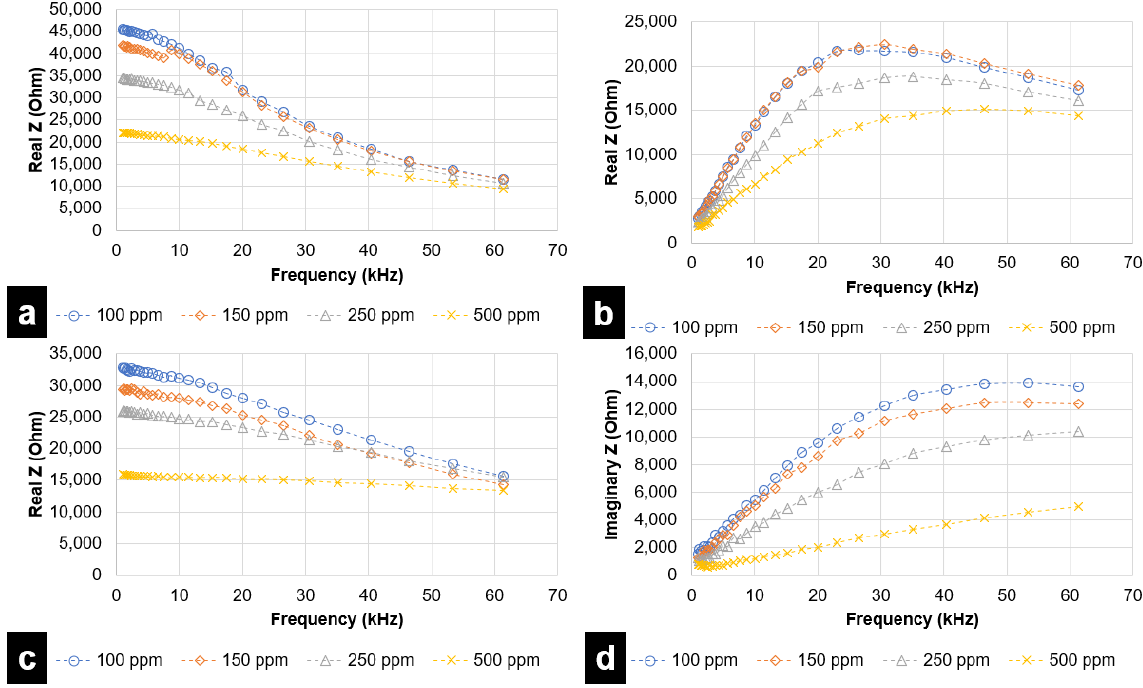
Figure 8. EIS analysis for GMP (umami) and sucrose (sweet), in the range of 1 kHz to 62 kHz, for inkjet printing-based IDE sensor in terms of ( a ) Resistive Impedance vs. Frequency (GMP) ( b ) Reactive Impedance vs. Frequency (GMP) ( c ) Resistive Impedance vs. Frequency (sucrose) ( d ) Reactive Impedance vs. Frequency (sucrose).